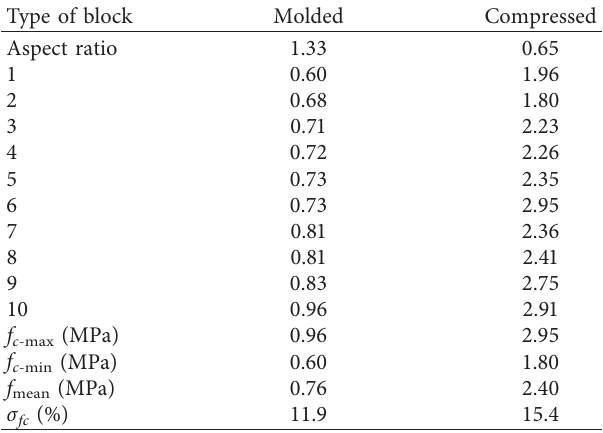
Figure 5: Failure modes of stacked half-blocks. (a) Molded adobe. (b) Rammed adobe. Table 7: Compressive strength measured directly on stacked half- blocks and cube